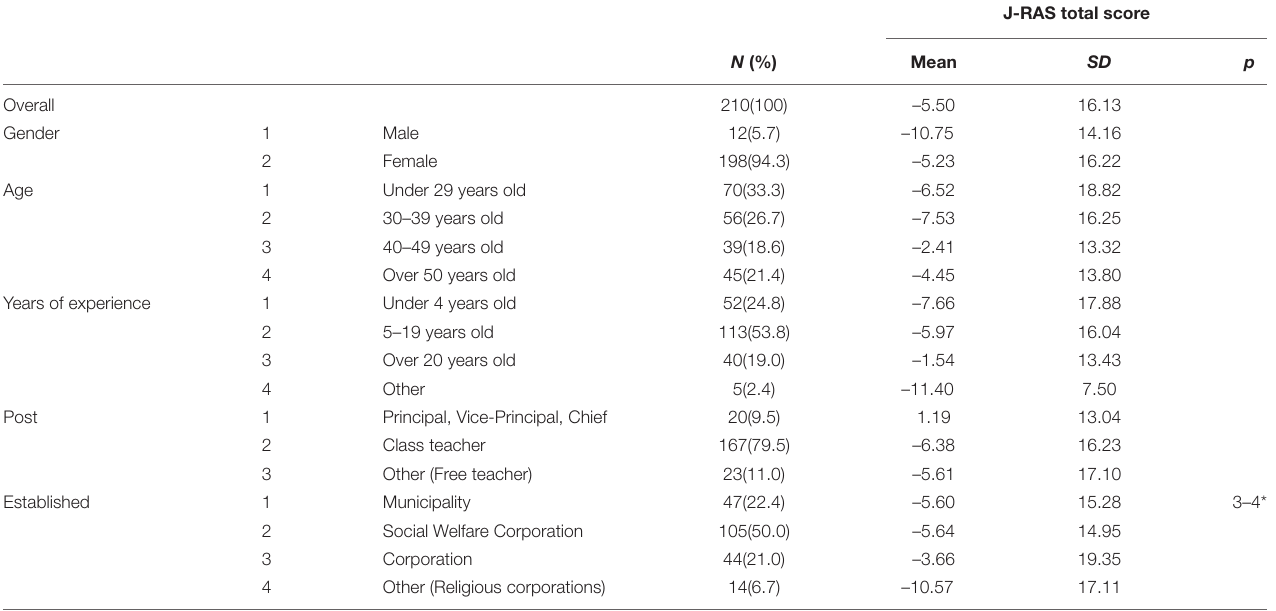
TABLE 1 | Distribution of personal attributes and assertiveness scores.